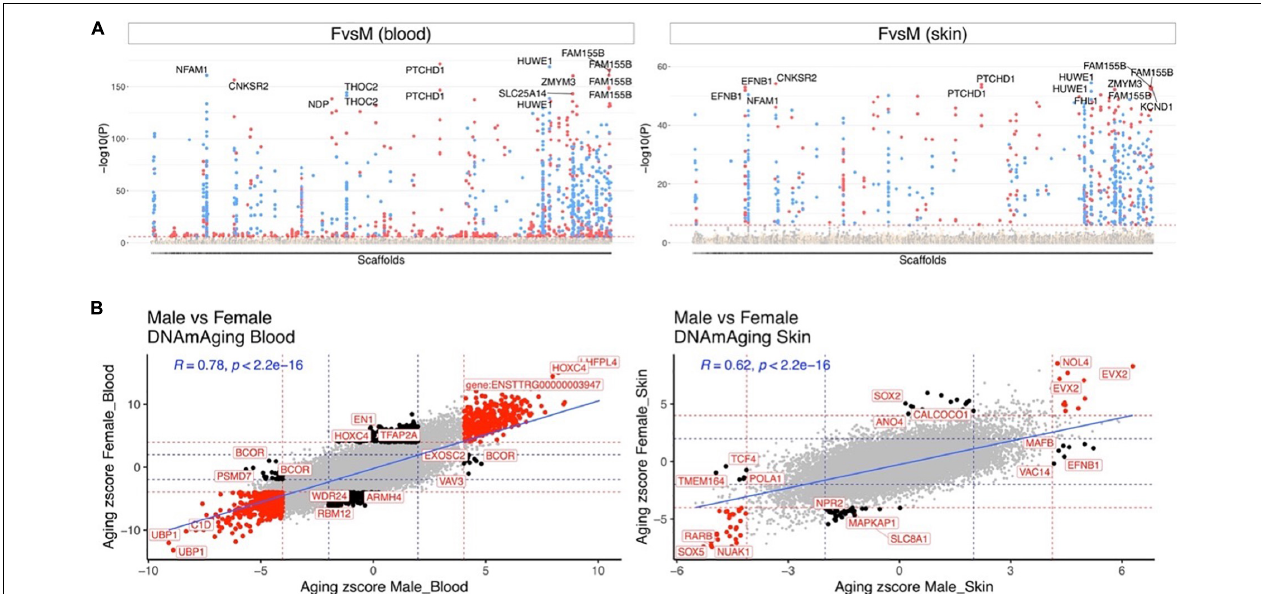
FIGURE 3 | Aging effects in male and female dolphins. (A) Manhattan plot of the epigenome-wide association studies (EWAS) of sex. We adjusted the analysis for chronological age. Sample size: males blood, 45; females blood, 95; males skin, 29; and females skin, 58. The genome coordinates are estimated based on the alignment of Mammalian array probes to the bottle nose dolphin (turTru1.100) genome assembly. The horizontal red dotted line indicate a nominal/uncorrected significance level of P < 10 − 4 . Significant CpGs are colored in red if they are hypermethylated in females, blue hypomethylated in females. The 15 most significant CpGs are labeled by their respective neighboring genes. (B) Sector plot of DNA methylation aging effects by sex in blood (left) and skin (right). Red dotted line: P < 10 − 4 ; blue dotted line: P > 0.05; Red dots: shared CpGs; black dots: distinct changes between males and